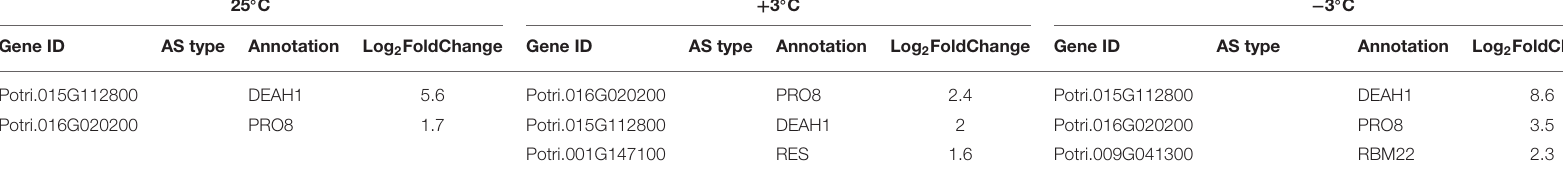
TABLE 5 | Expression change of splicing-associated factors in P. ussuriensis compared with P. trichocarpa at different temperatures. 25 ◦